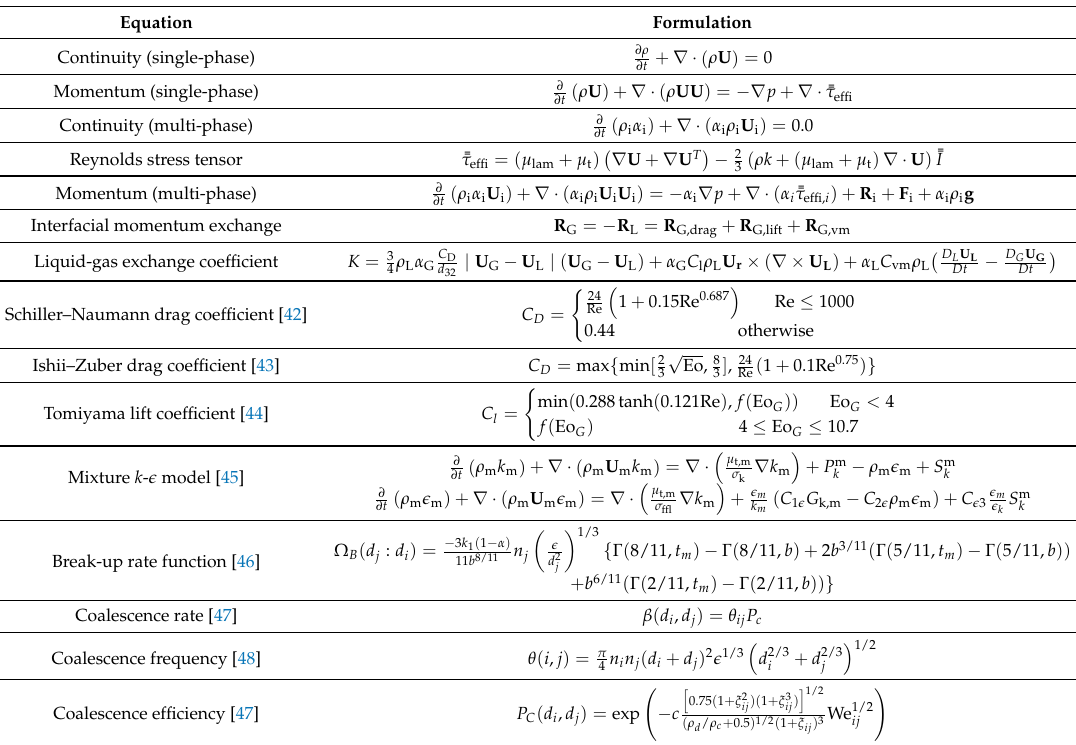
Table 3. Governing equations of the CFD-PBM